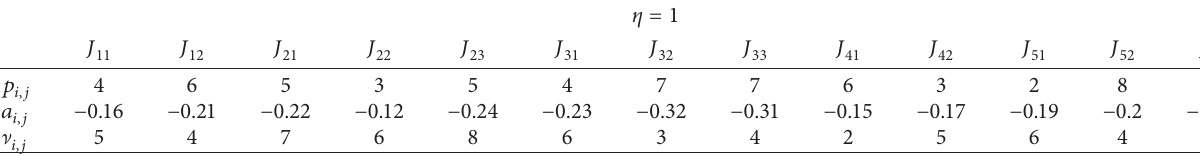
Table 2: Numerical